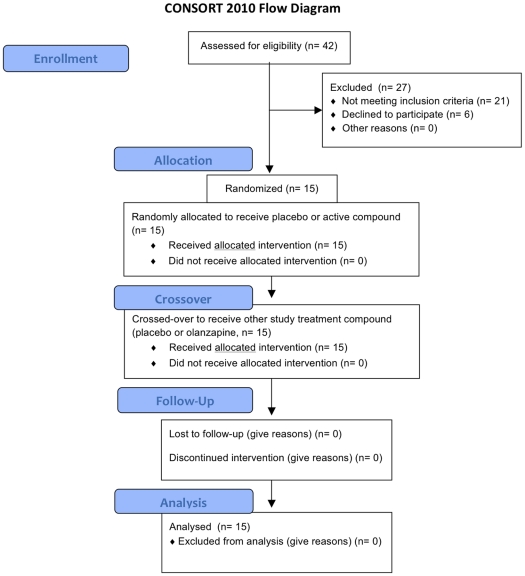
CONSORT 2010 Flow Diagram.The schema graphically outlines the design and conduct of the clinical study.